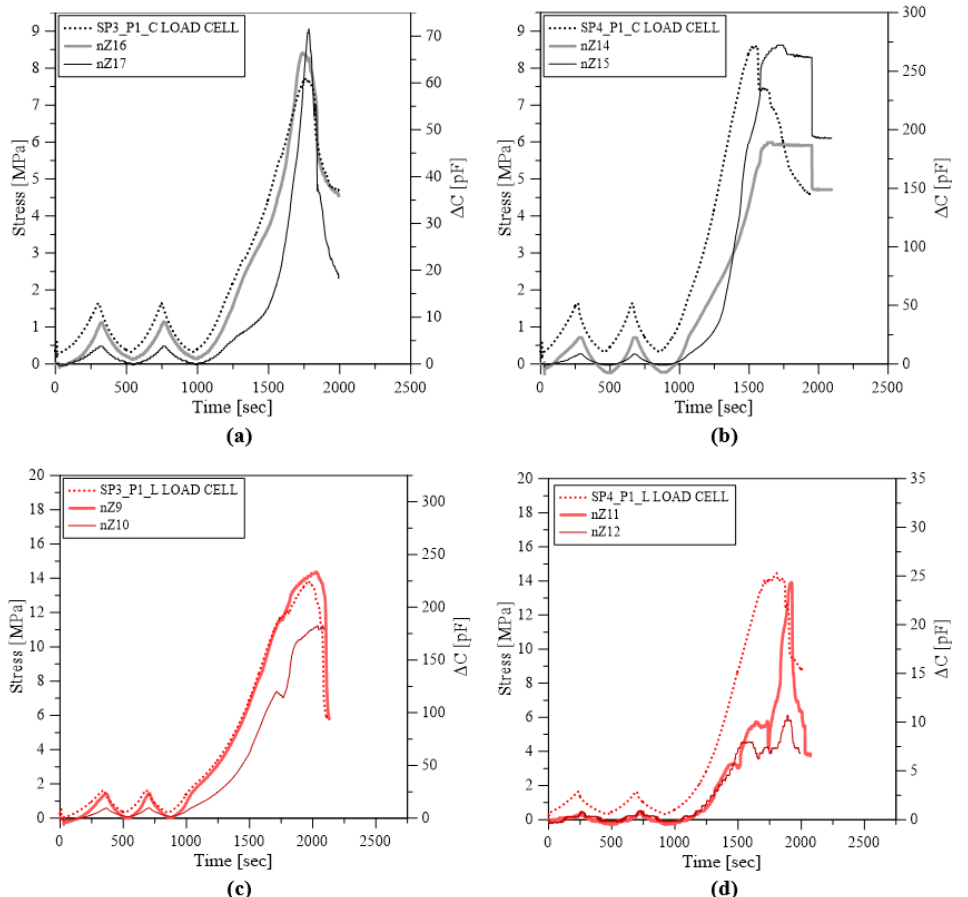
Figure 12. Comparison of outcomes from capacitive sensor and load cell, for post-installation system